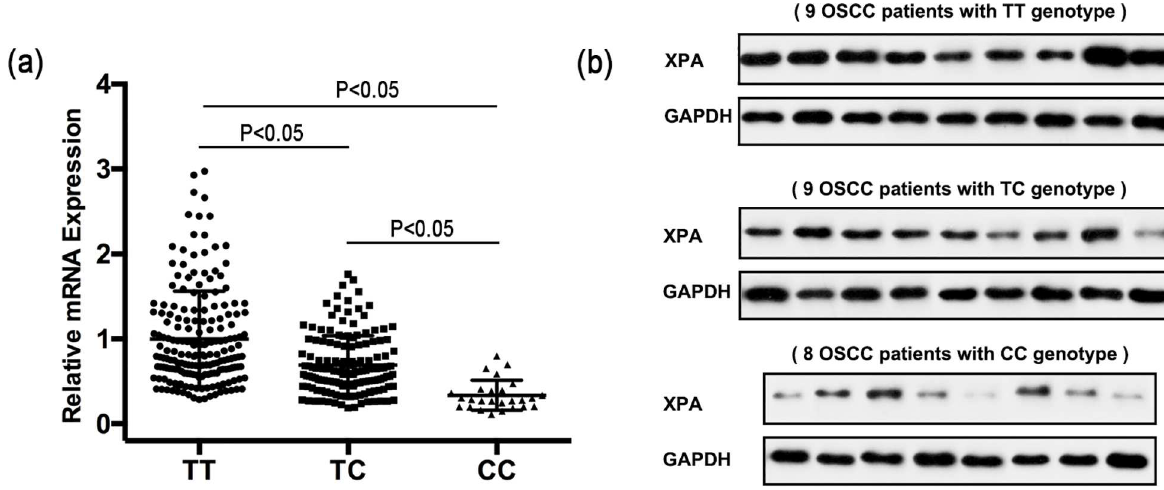
Fig 3. Association betweenrs10817938 polymorphism and XPA mRNA and proteinexpressionin OSCC patients. (a) XPA mRNA expression in OSCC tumortissues fromindividualswith differentrs10817938 genotypes was measuredusing qRT-PCR; (b) XPA proteinwas measuredwith westernblot in threegroups of OSCC patients.OSCC patientswith TT genotype(n = 9), TC genotype (n = 9) or CC genotype (n = 8).